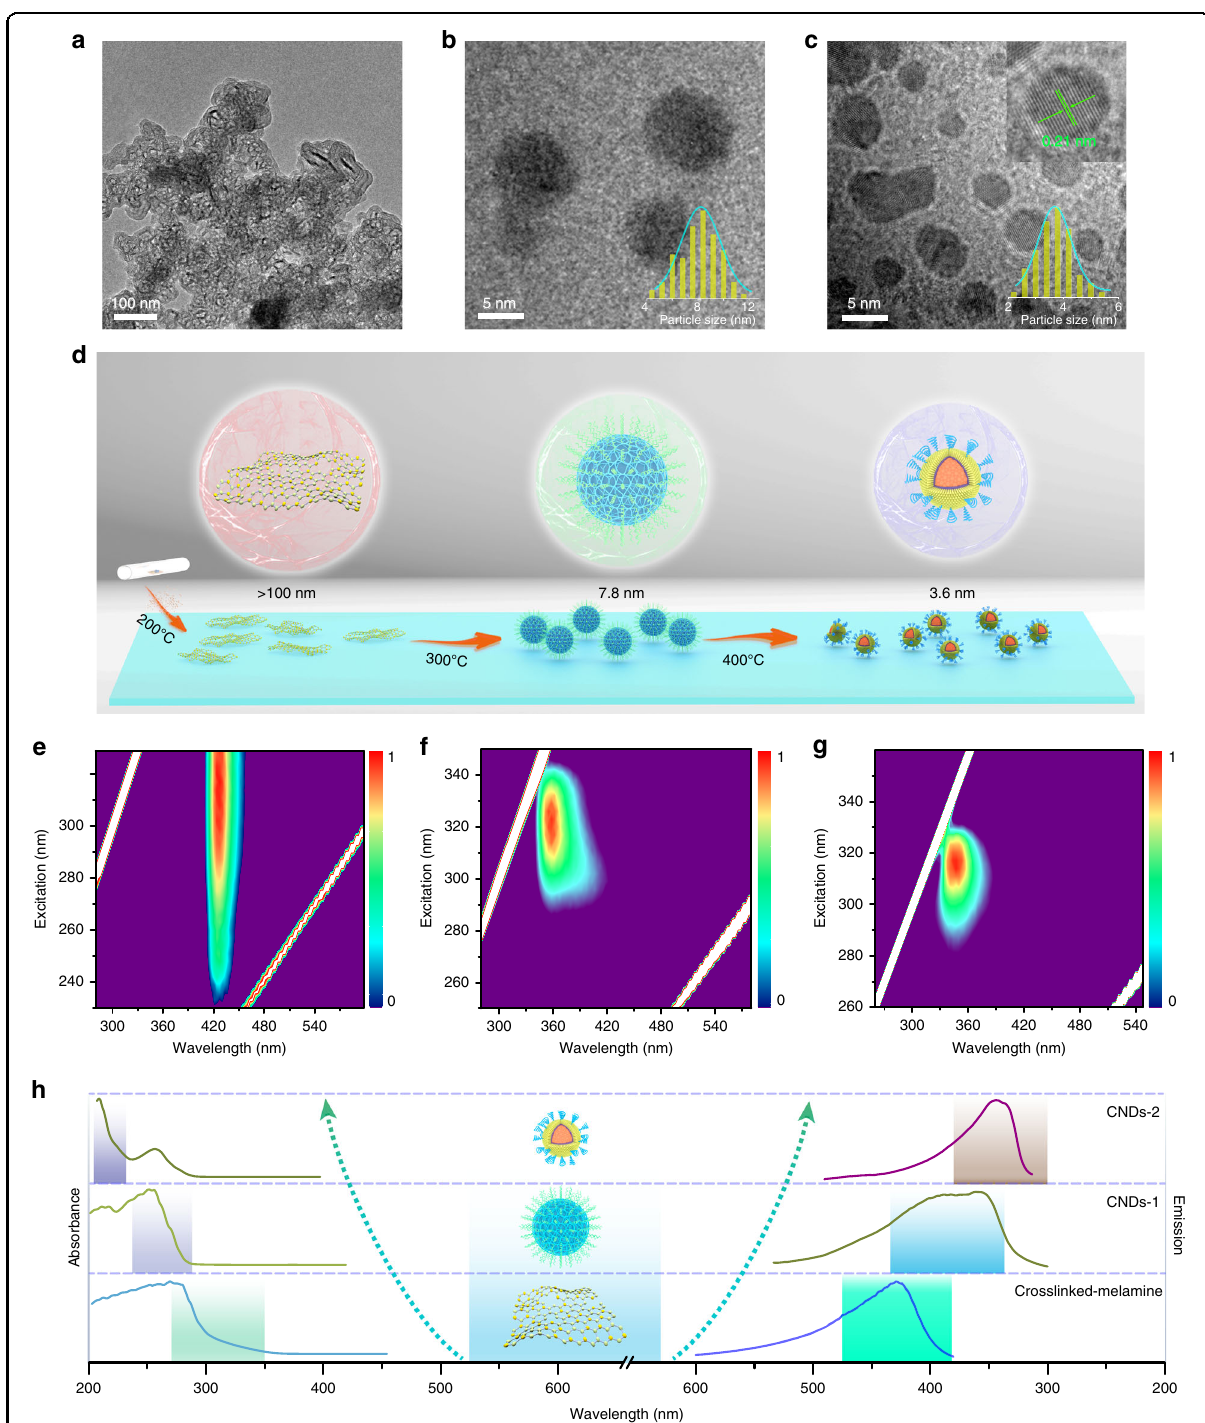
Fig. 2 The formation process and fl uorescence characterization. TEM images of crosslinked melamine at 200 °C ( a ), CNDs formed at 300 °C ( b ) and CNDs formed at 400 °C ( c ). The insets are the size distributions and high-resolution TEM images of the CNDs. d Schematic diagram of the formation mechanism of the CNDs under different conditions. Excitation- fl uorescence mapping pro fi les of crosslinked melamine@Na 2 CO 3 ( e ),